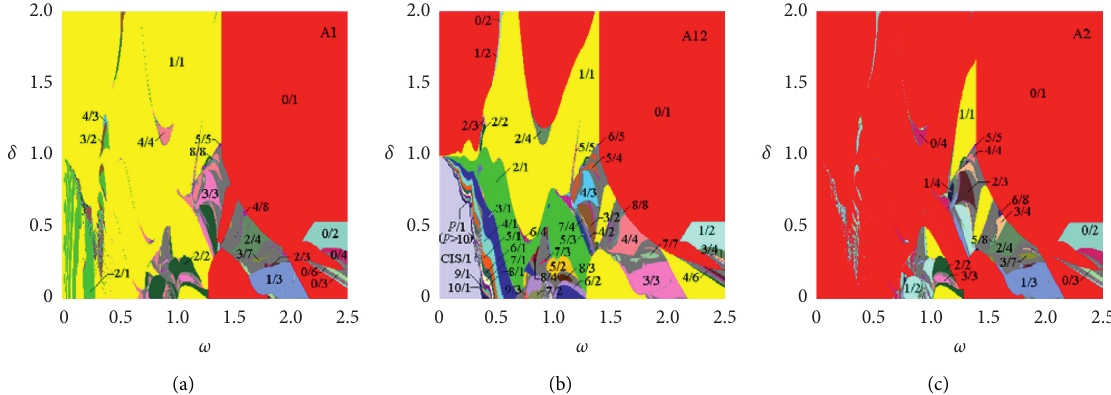
Figure 2: Periodic motions on the ( ω , δ ) -parameter plane associated with each constraint. (a) Constraint A (c) constraint A 2